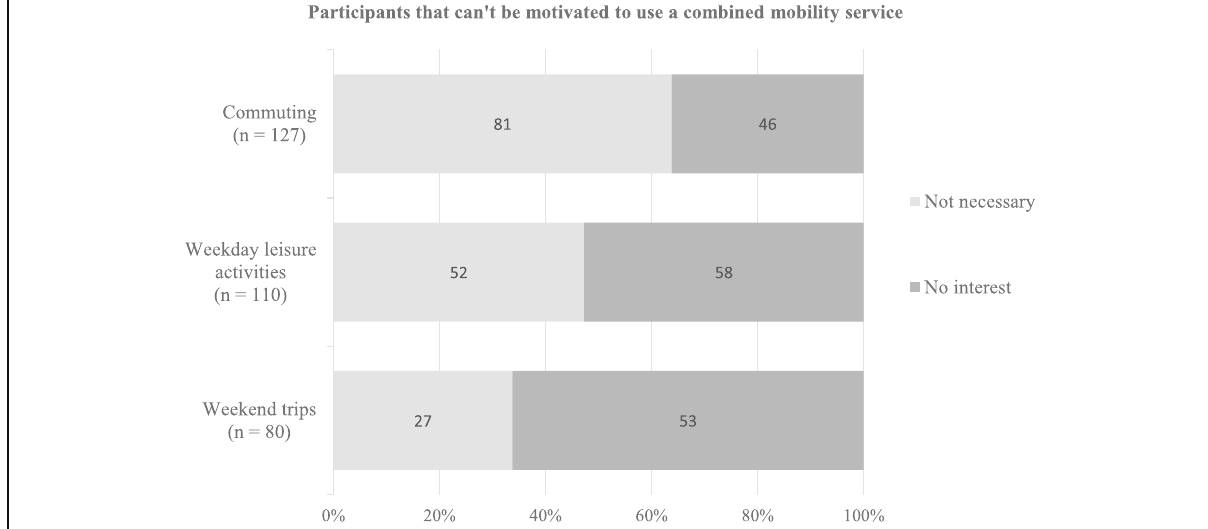
Fig. 3 Number of participants that did not mention any reason that could motivate them to use a combined mobility service, either saying it ’